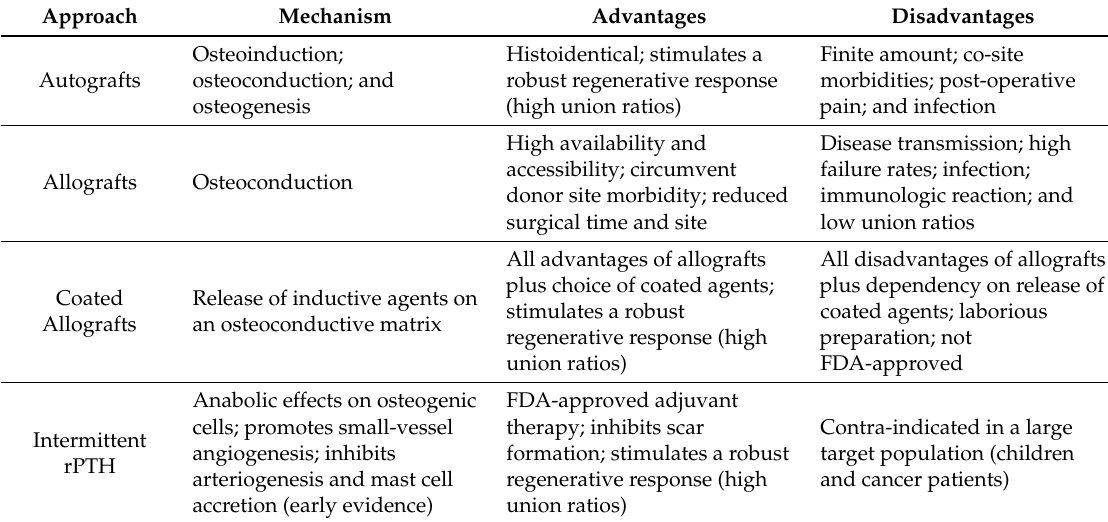
Table 1. A summary of bioengineering solutions for critical bone defect repair and